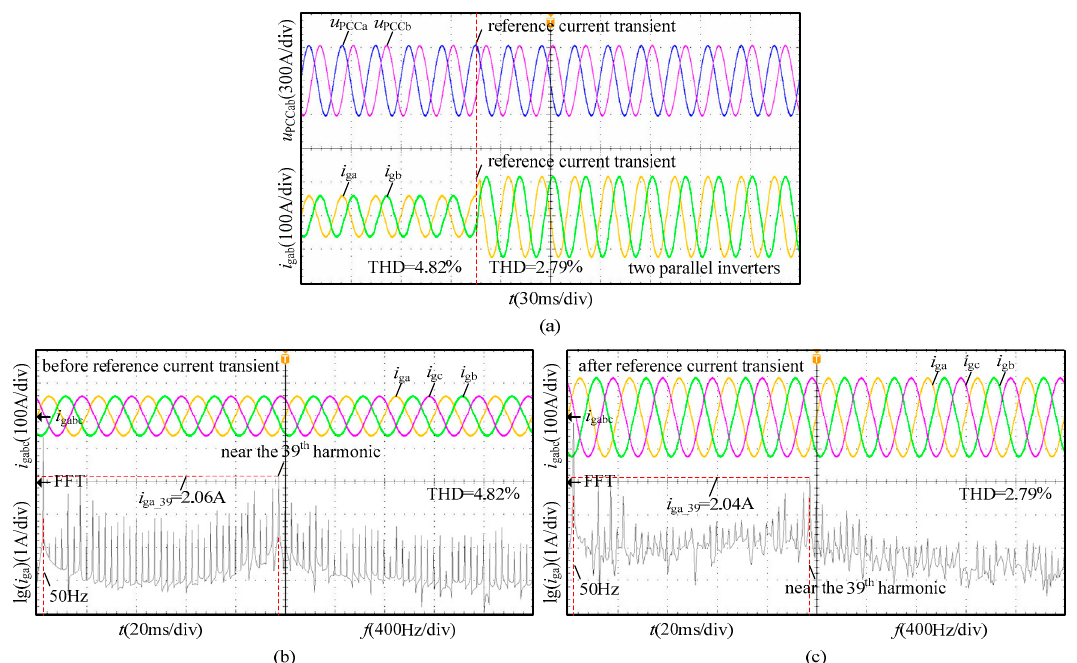
Figure 18. Experimental waveforms of PCC voltage u PCC and grid-connected current i g in case II during reference current transient (two parallel inverters). ( a ) PCC voltage u PCC and grid-connected current i g ; ( b ) grid-connected current i g and spectrogram (before); ( c ) grid-connected current i g and spectrogram (after).